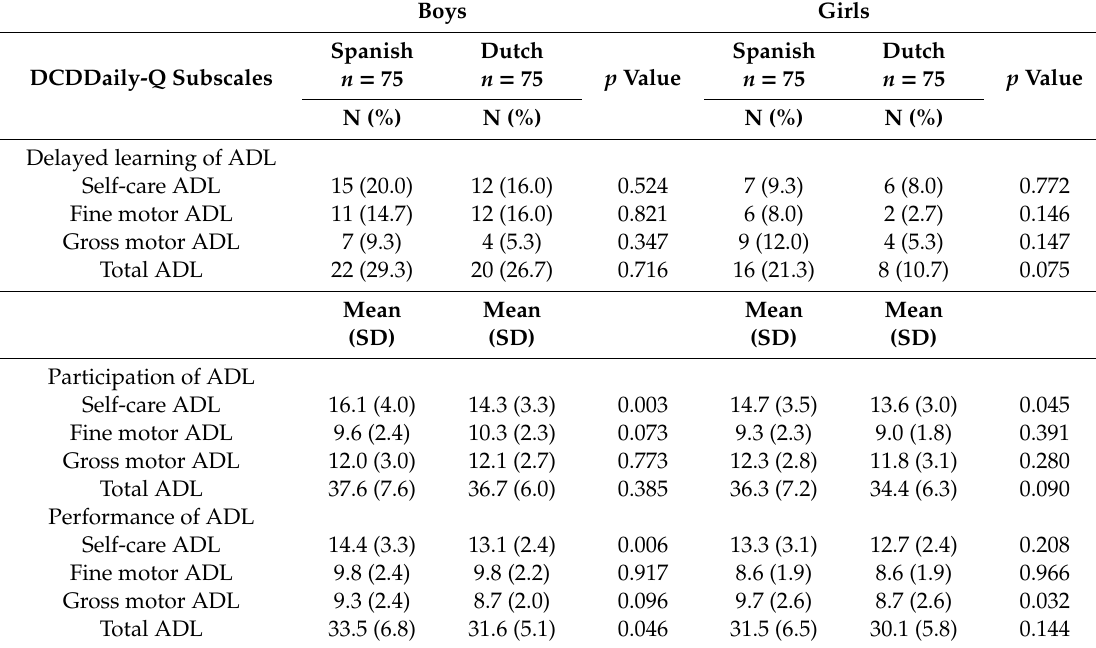
Table 3. Di ff erences in learning, participation, and performance of ADL in Spanish and Dutch children according to sex ( n =